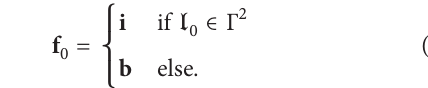
(cid:6) (cid:24) ) and composed to the word (cid:4)#I(cid:24)(cid:8)I(cid:23)(cid:8)(cid:6)